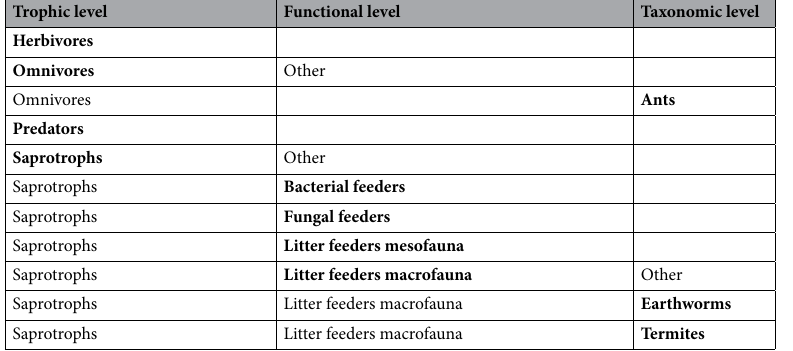
Table 1. Main classification of soil fauna functional groups with bold terms used in text. Soil fauna functional groups: Bacterial feeders Protists, bacterivorous nematodes, dipteran larvae, rotifers, tardigrades. Fungal feeders Oribatid mites, collembolans, pauropods, proturans, fungivorous nematodes. Herbivores Gastropods, hemipterans, homopterans, herbivorous nematodes. Litter feeding macrofauna Unidentified soil fauna